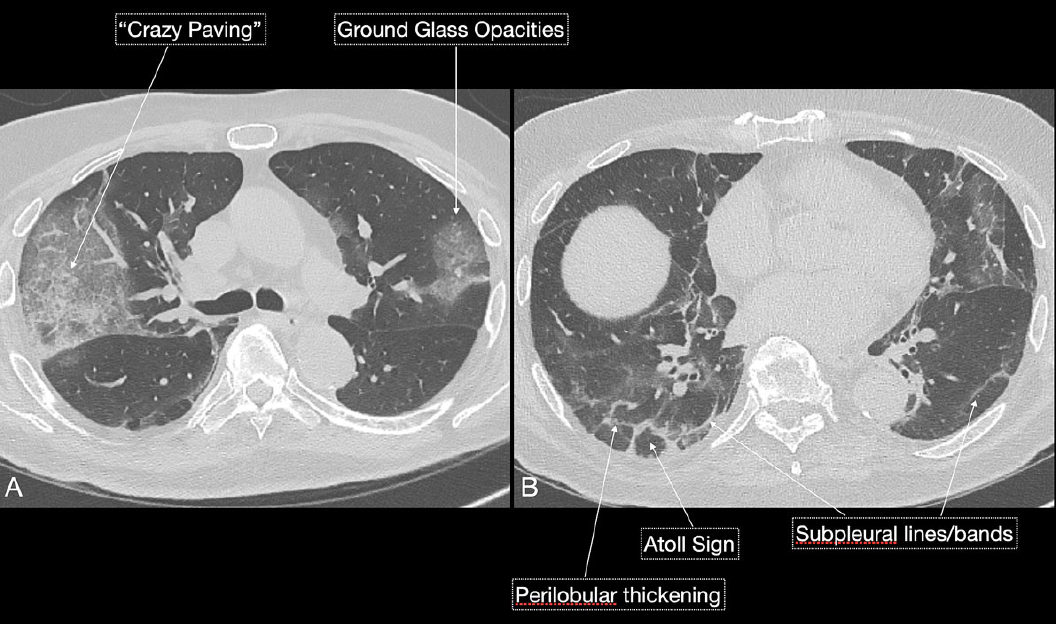
Figure 7: An 84-year-old male patient presented to the emergency department with fever and cough for 4 days after returning from a cruise ship. Intermitted diarrhoea was reported. Nasopharyngeal swabbing was performed, Chest CT was initiated owing to shortness of breath and abnormal Chest x-ray findings (not shown). Findings suggested later stage disease, with typical patterns of “crazy paving” and organising pneumonia. Subpleural lines, perilobular thickening and formation of atoll signs suggested advanced reparative state. The patient recovered from the infection and was discharged